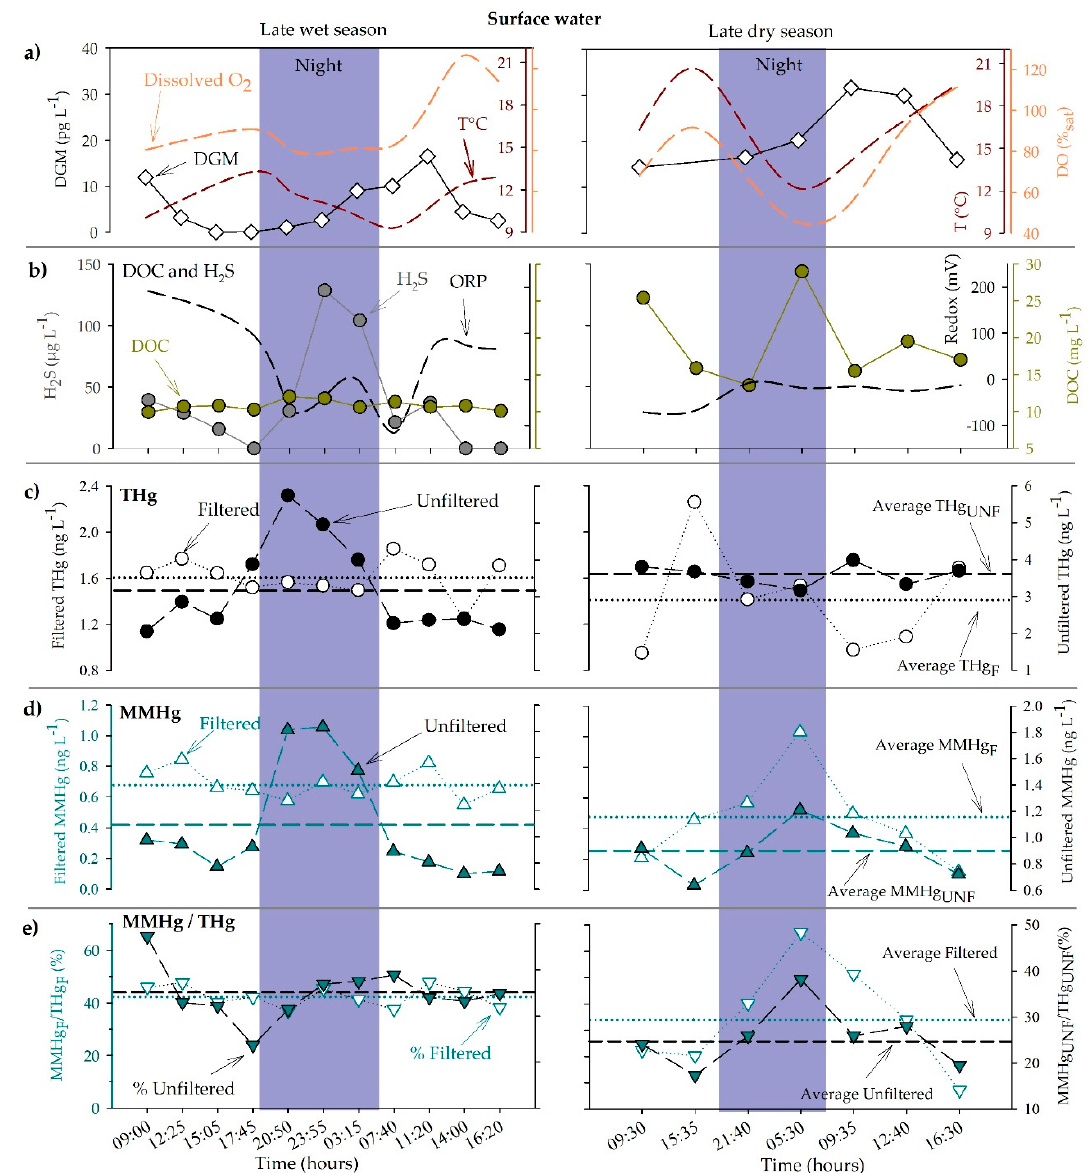
Figure 2. ( a ) Dissolved gaseous Hg (DGM), dissolved oxygen saturation percentage (% sat ), and temperature (T °C); ( b ) dissolved organic carbon (DOC), hydrogen sulfide (H 2 S), and redox potential (ORP); ( c ) filtered (F, empty symbols) and unfiltered (UNF, black symbols) THg concentrations; ( d ) filtered (F, empty symbols) and unfiltered (UNF, dark cyan symbols) MMHg concentrations; and ( e ) percentage MMHg over the THg concentrations in the F (empty symbols) and UNF (dark cyan symbols) in surface water during the wet (left panels, 20–21 May 2014) and the dry (right panel, 18th to 19th November 2014) seasons. Lines represent average concentrations for F (dotted line) and UNF (dashed line) species and